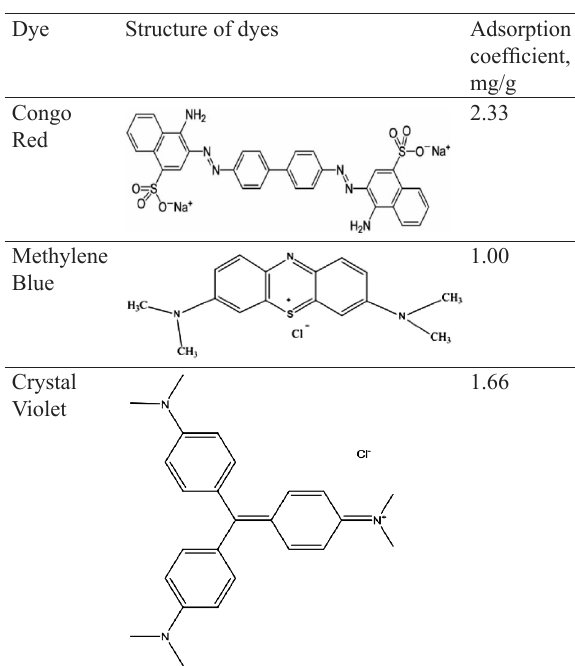
Table 3 pH of dye solutions before and after treatment with